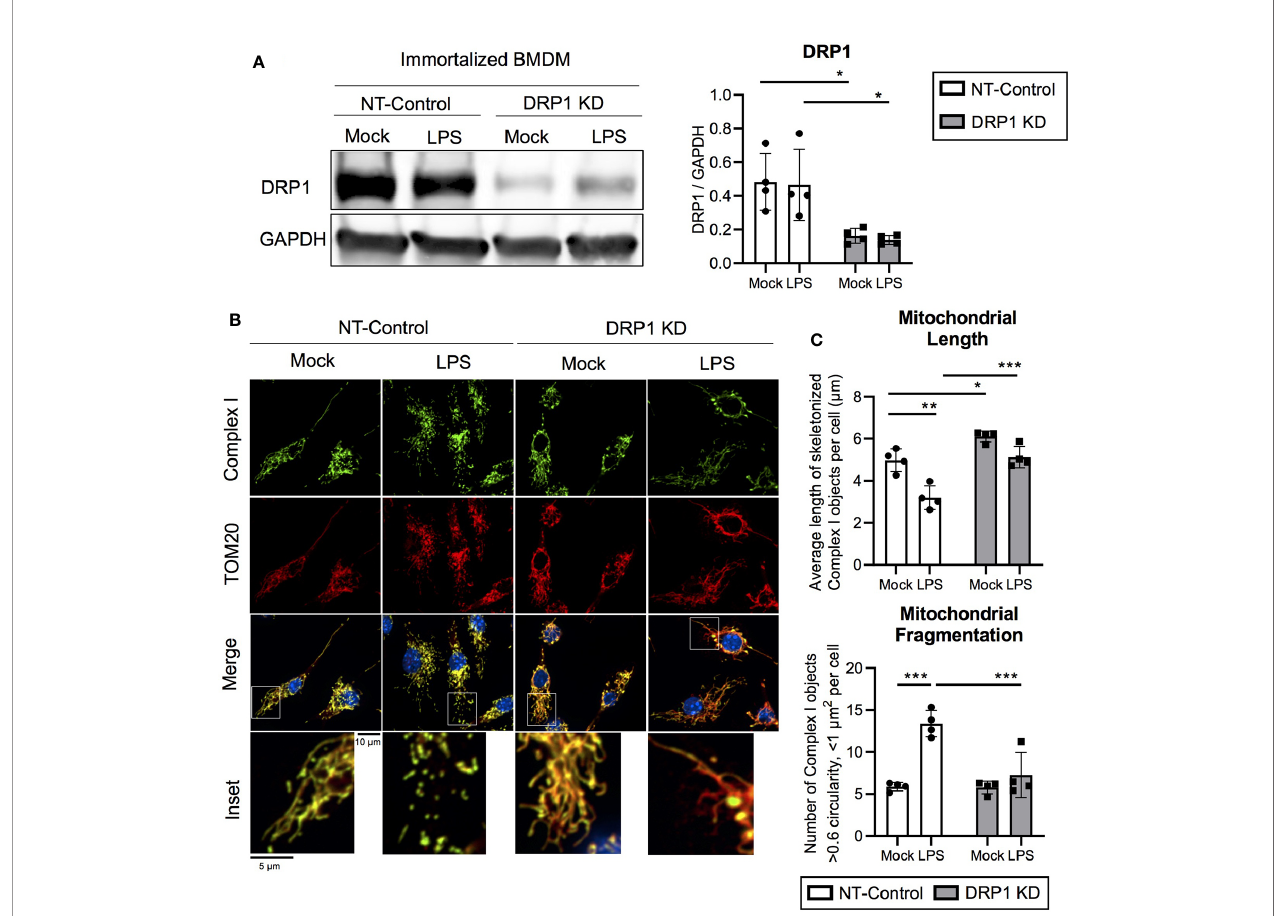
FIGURE 1 | DPR1 is required for LPS-induced mitochondrial fragmentation. (A) Representative immunoblot analysis and quanti fi cation of total DRP1 protein in NT-Control and DRP1 KD immortalized Bone marrow- derived macrophage cell lines which were left untreated (Mock) or stimulated for 4h with 200 ng/ml LPS. (B) Representative confocal immuno fl uorescence images of NT-control and DRP1 KD macrophages stained for TOM20 (red), Complex I (green) and DAPI (blue) after 4h LPS stimulation. (C) Quanti fi cation of mitochondrial length and fragmentation was performed based on Complex I images of Mock and LPS-stimulated macrophages using CellPro fi ler image analysis software. Graphs are presented as mean of n=4 independent experiments with standard deviation (SD) error bars. P value was calculated using two-way ANOVA with Sidak ’ s post-test for multiple comparisons. * P < 0.05; ** P < 0.01; *** P <